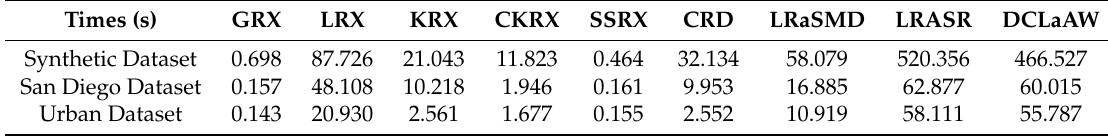
Table 4. Computational costs of all compared detectors for each